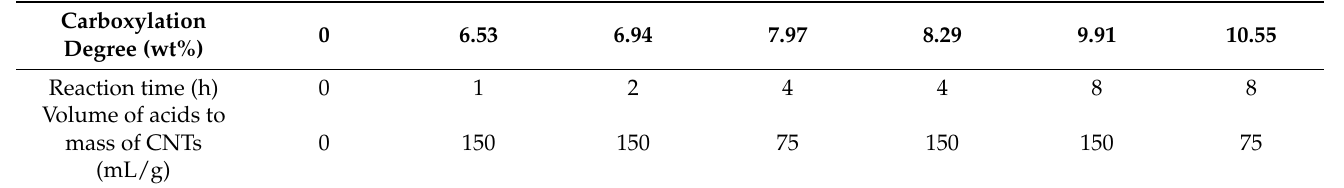
Table 1. The reaction circumstances were applied to obtain different degrees of carboxylation of MWCNTs [52].